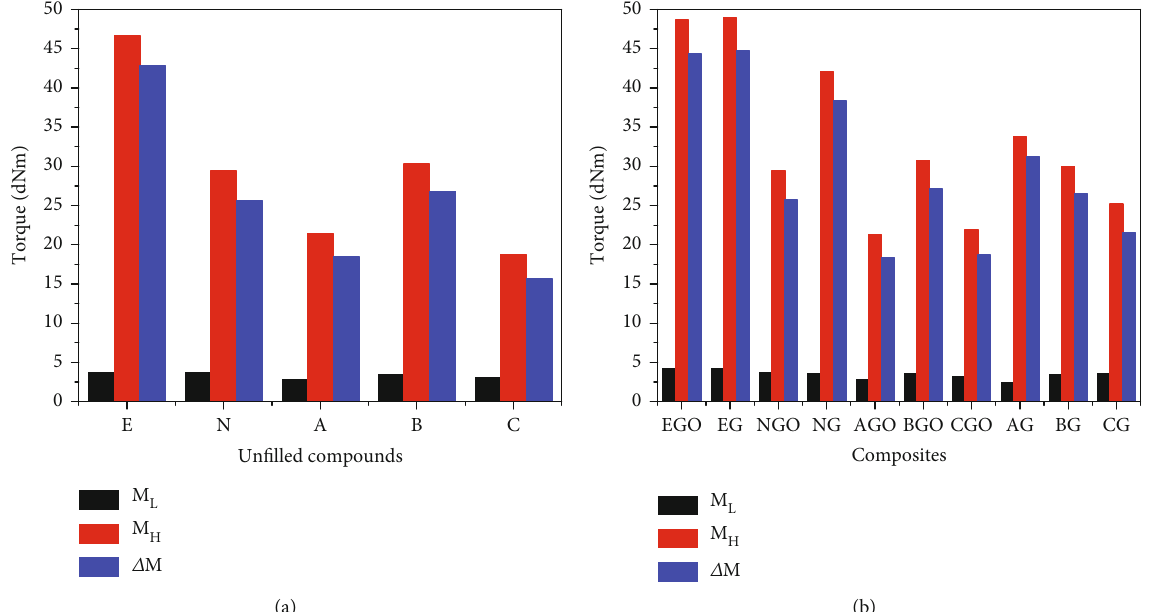
Figure 7: Torque properties of the single, blends, and their composites with GO and G. (a) The un fi lled matrices of the single and blend; (b) fi lled matrices of the single and